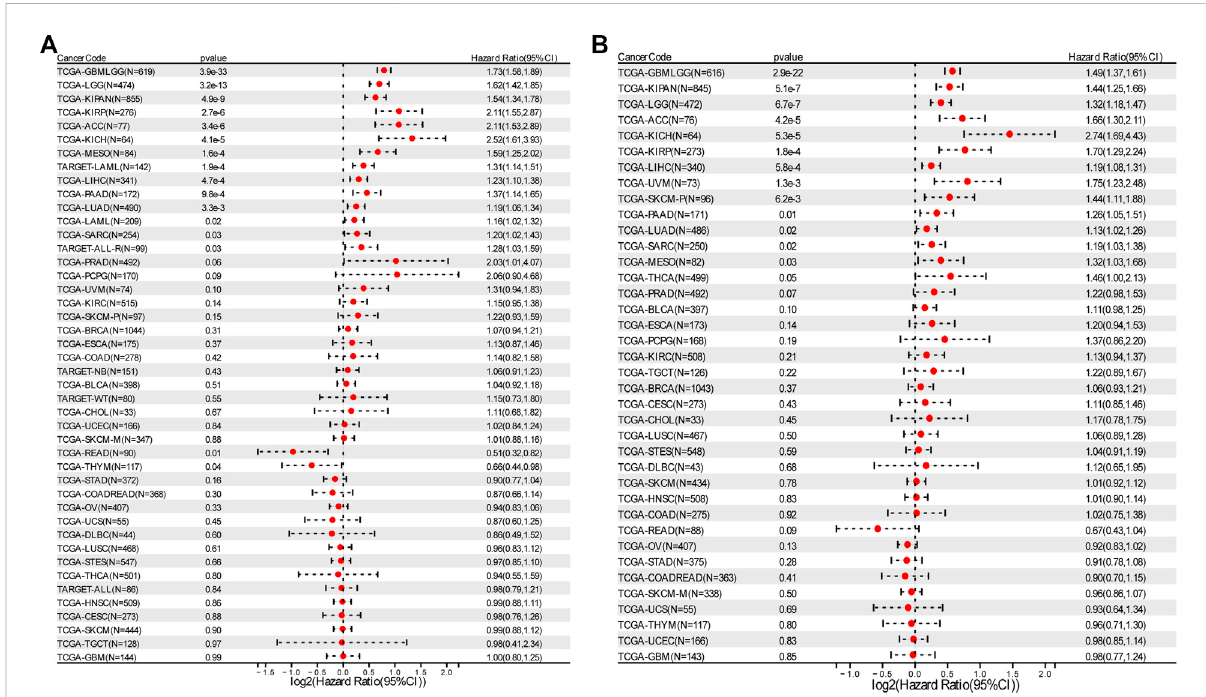
FIGURE 3 Survival analysis of RAD51AP1 in pan-cancer. (A) 43 cancer types were analyzed using R software ’ s coxph function. High expression RAD51AP1 signi fi cantly correlated to the poor OS in GBMLGG, LGG, LAML (from TCGA and TARGET database), LUAD, SARC, KIRP, KIPAN, LIHC, MESO, PAAD, ACC, ALL-R, and KICH. Conversely, in READ and THYM, low expression of RAD51AP1 is signi fi cantly linked to poor prognosis. (B) PFS analysis of 38 cancer types showed poor prognosis of GBMLGG, LGG, LUAD, SARC, KIRP, KIPAN, LIHC, SKCM-P, MESO, UVM, PAAD, ACC, and KICH related to highly expressed